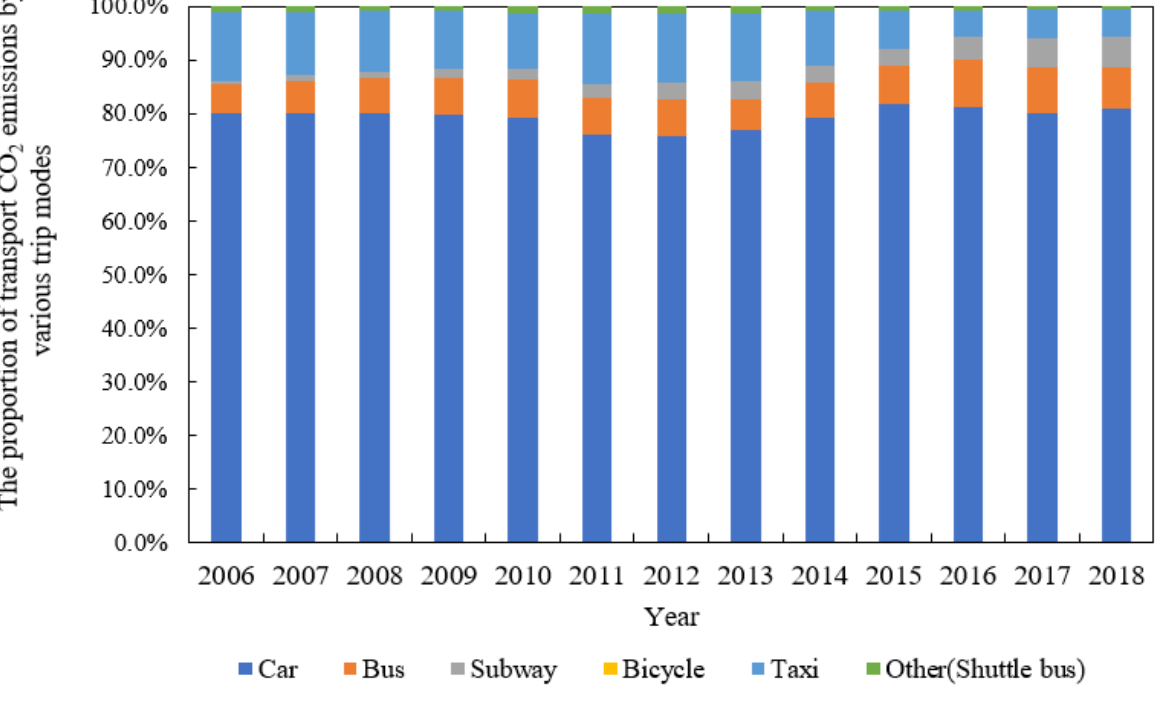
Figure 8. Proportion of transport-related CO 2 emissions from urban transport from 2006 to 2018. Table 4. Performance evaluation of financial investment policies in the transportation